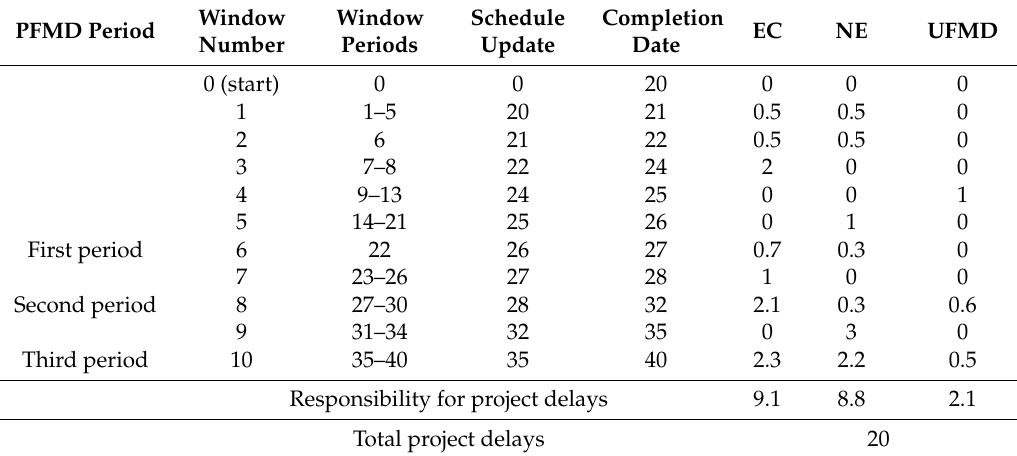
Table 9. The analysis results for the proposed method